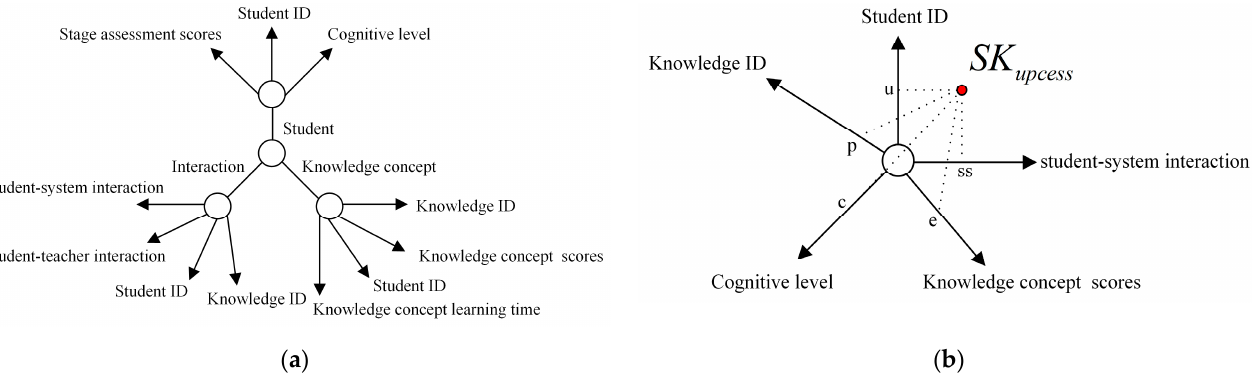
Figure 2. Tensor fusion and simplification. ( a ) Integrated student–knowledge concept tensor; ( b ) simplified integrated tensor.